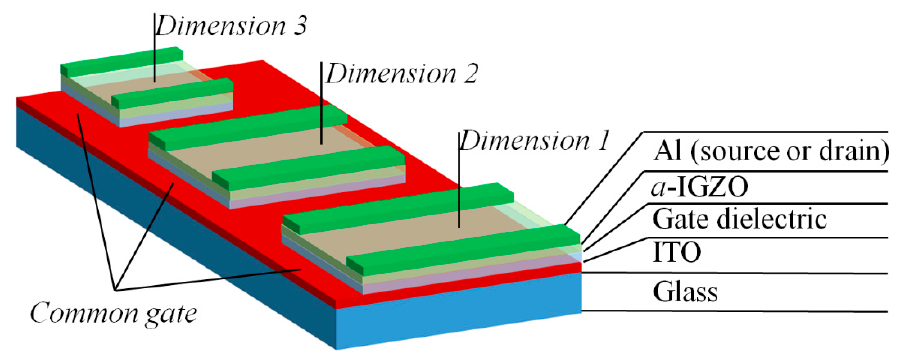
Figure 2. A schematic representation of the multiple dimension device structure.